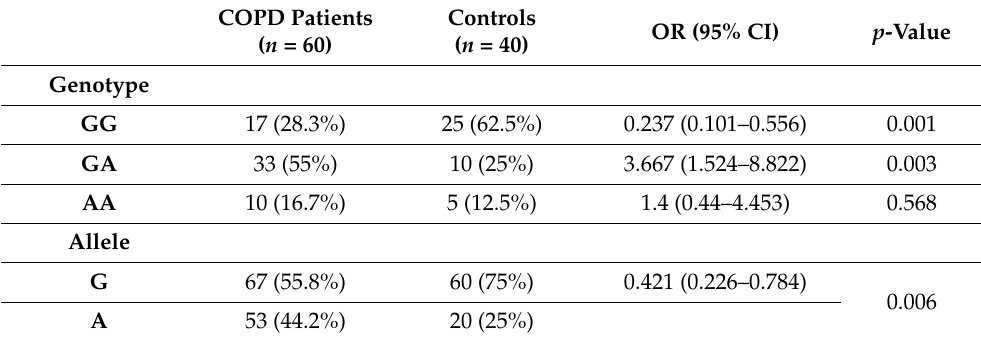
Table 3. Genotype and allele frequencies of RAGE rs2070600 gene polymorphism in COPD patients and